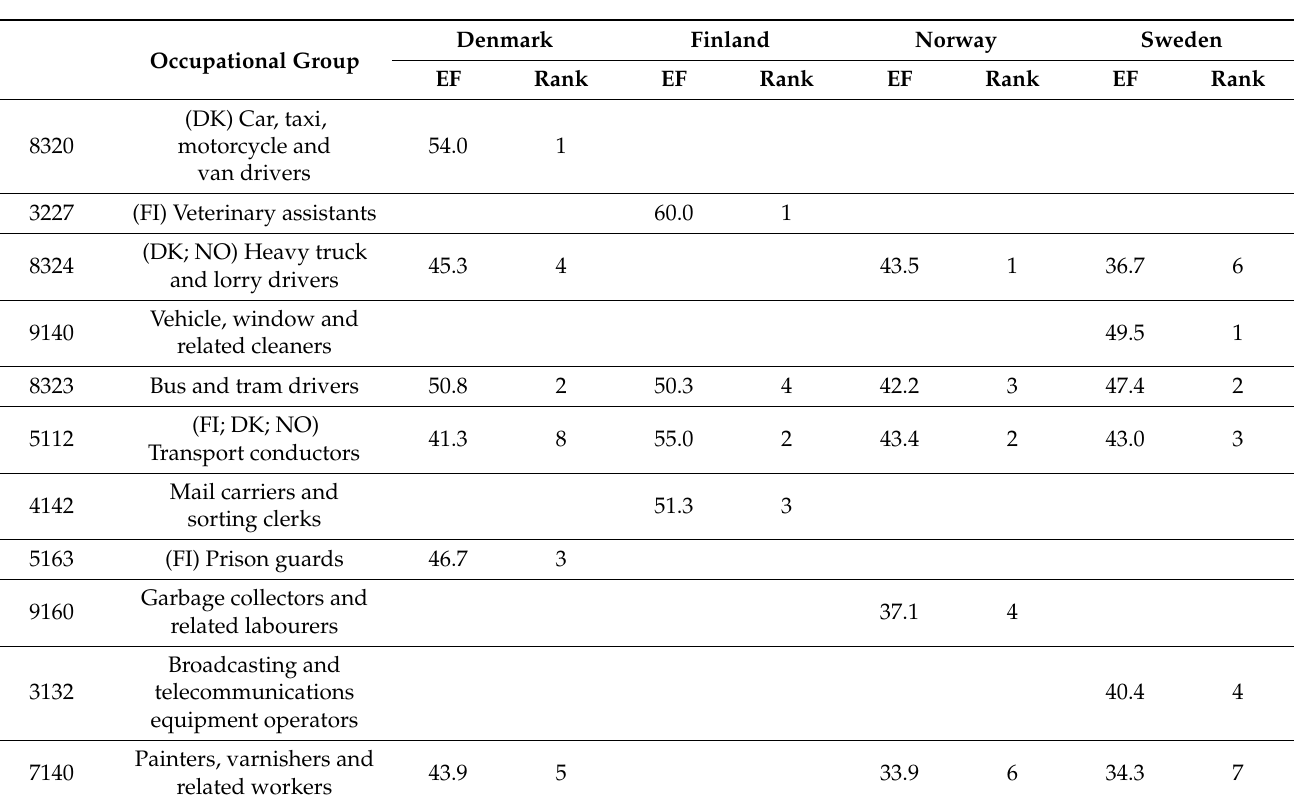
Table 2. Occupational groups with rank 1–10 based on the excess fraction (EF, %) of the age- adjusted one-year cumulative incidence of prolonged all-cause sickness absence among women in four Nordic